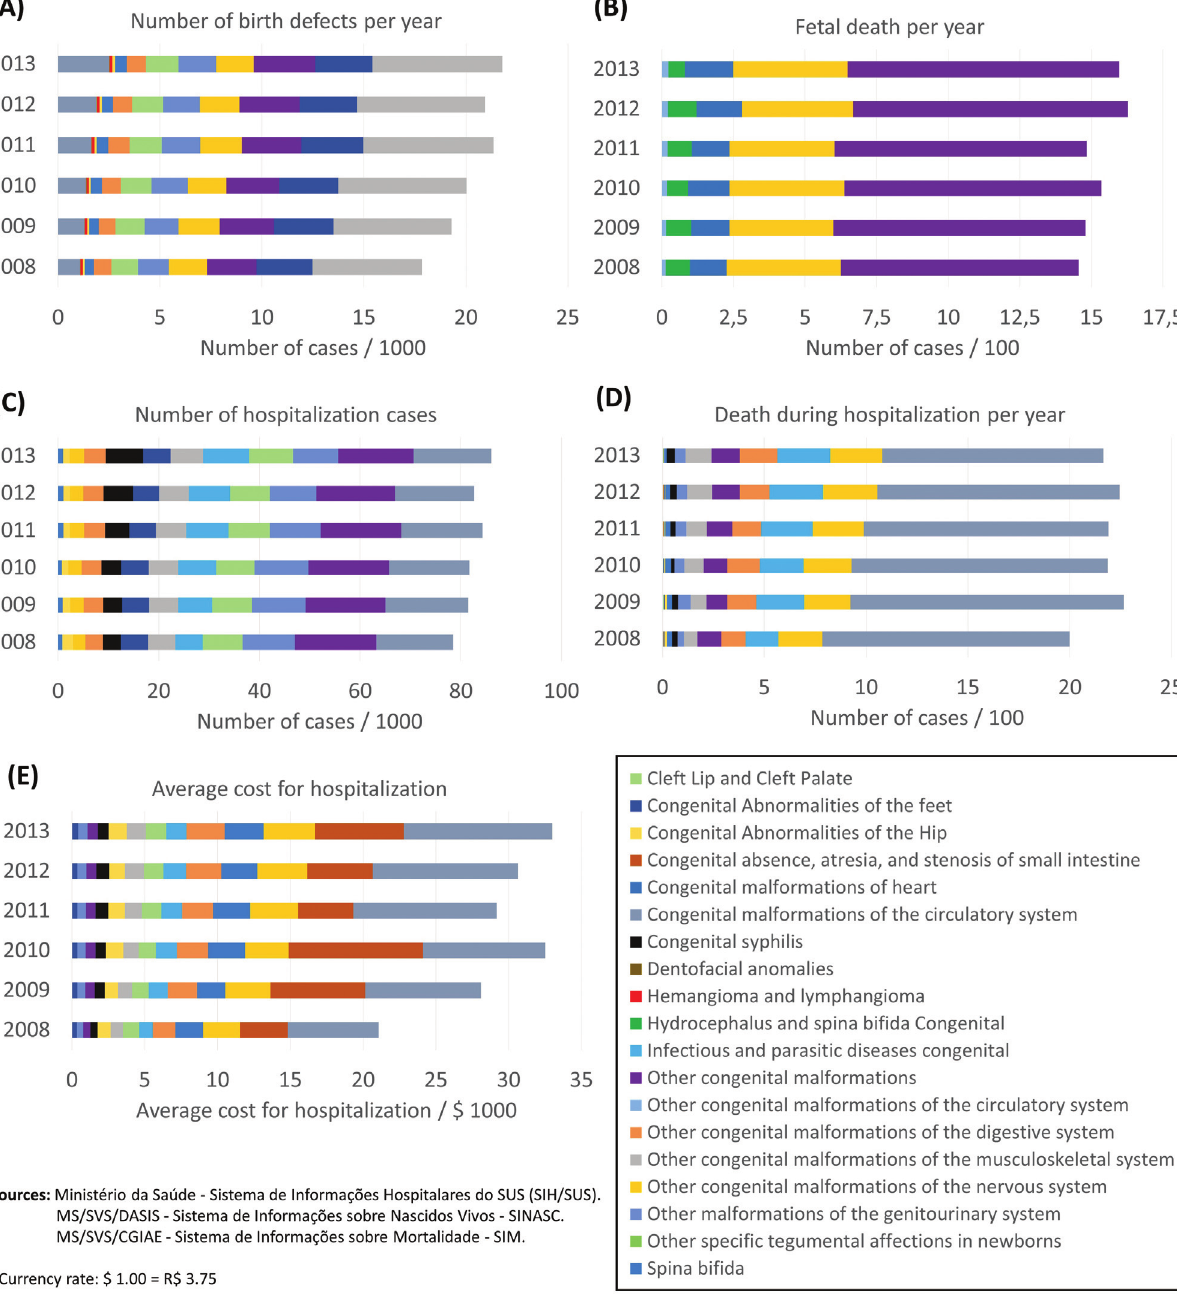
Figure 3 - Comprehensive survey of birth defects in Brazil from 2008 to 2013. A) Number of children born with birth defects. B) Number of fetal deaths. C)Numberofhospitalizationsinvolvingbirthdefectsperyear.D)Numberofdeathsofhospitalizedpatientsduetobirthdefects.E)Costsassociatedwith treatment and on hospitalization’s